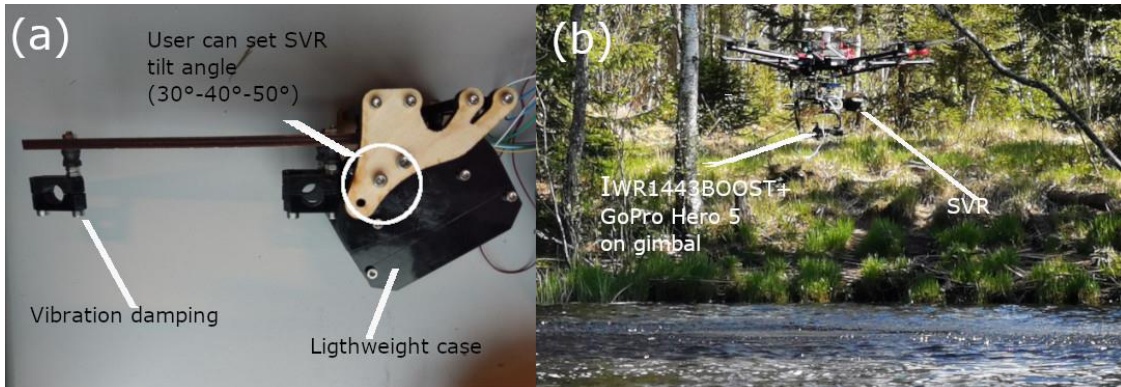
Figure 1. Pictures of UAS payload. ( a ) SVR adaption for being used as drone payload ( b ) UAS flight with SVR Doppler radar, IWR1443BOOST radar and GoPro Hero 5 RGB camera.